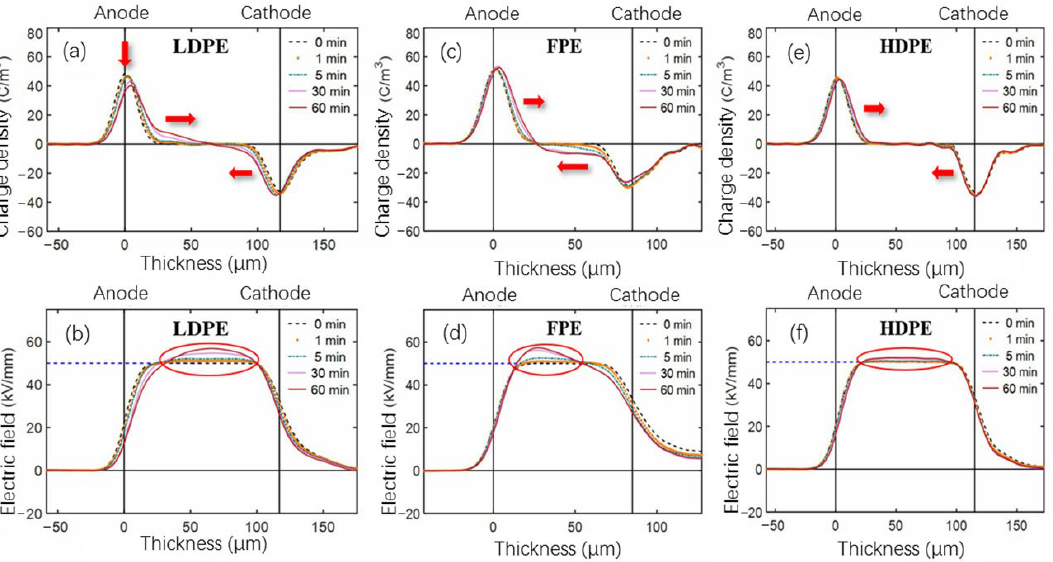
Figure 14. ( a , c , e ) Space charge and ( b , d , f ) electric field distribution of single-layer 360 h aged LDPE, FPE, and HDPE samples polarized for 60 min under − 50 kV/mm, respectively.